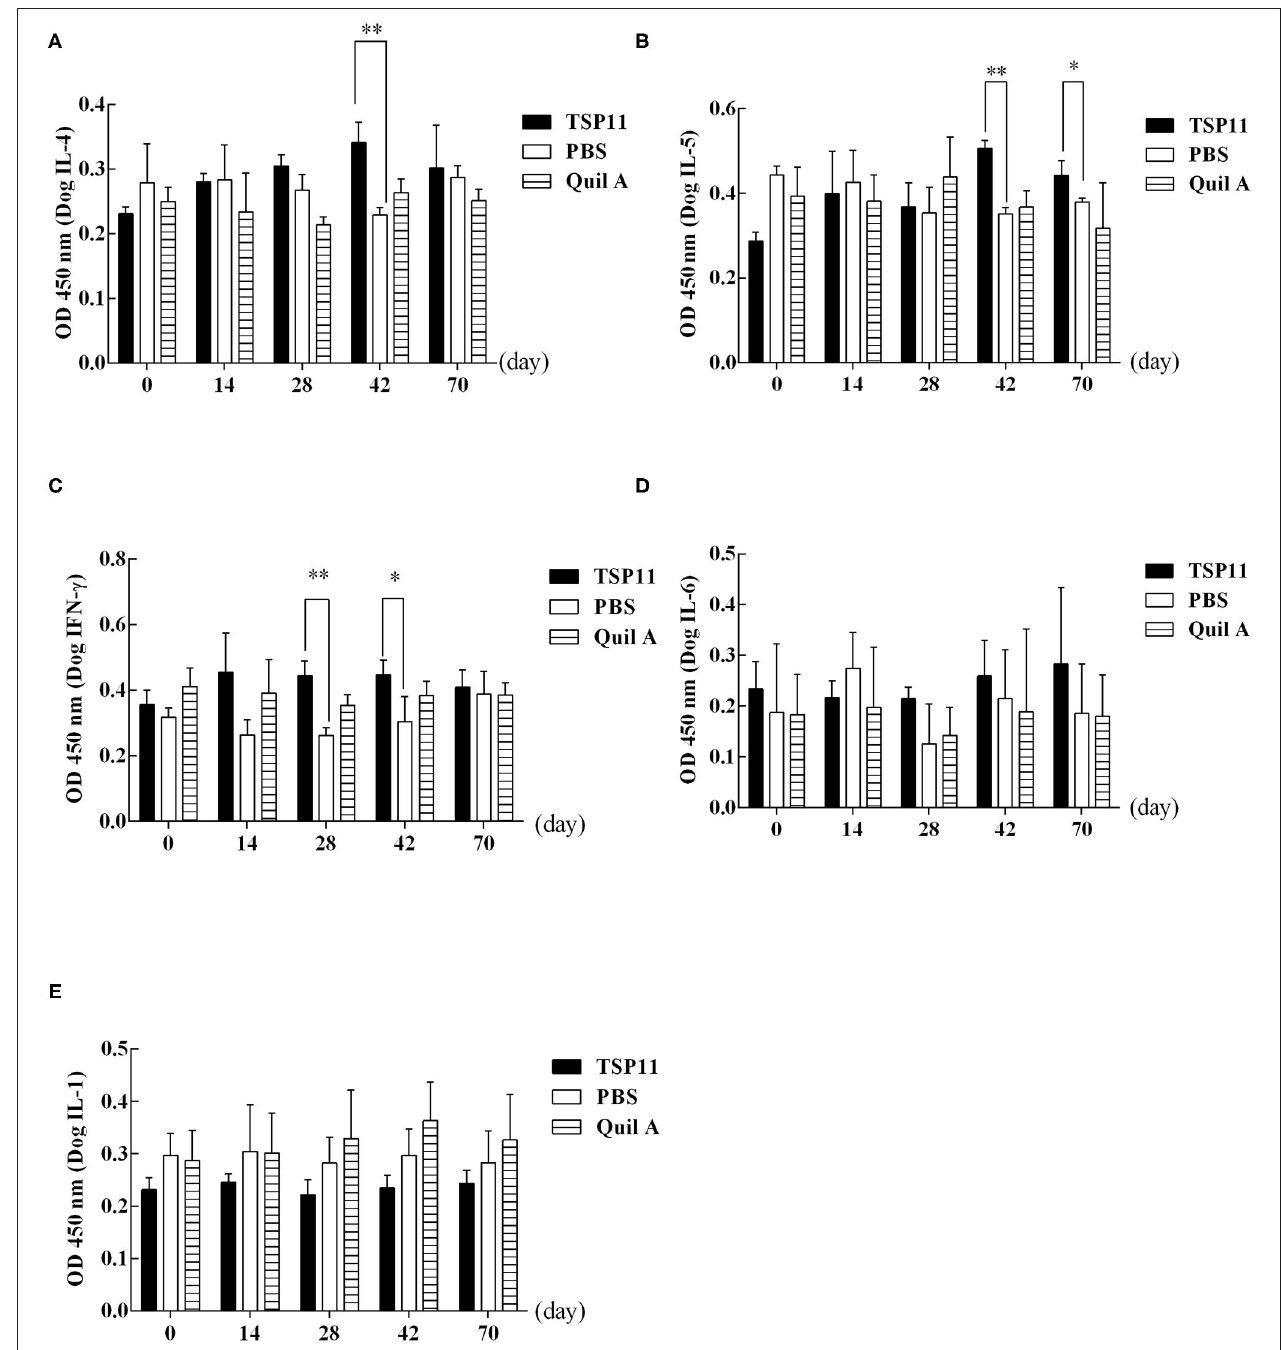
FIGURE 9 | ELISA detection of the levels of different cytokines in dogs vaccinated with rTSP11 + Quil A, Quil A alone, or PBS. (A) IL-4, (B) IL-5, (C) IFN- γ , (D) IL-6, E: IL-1. * P < 0.05; ** P < 0.01.